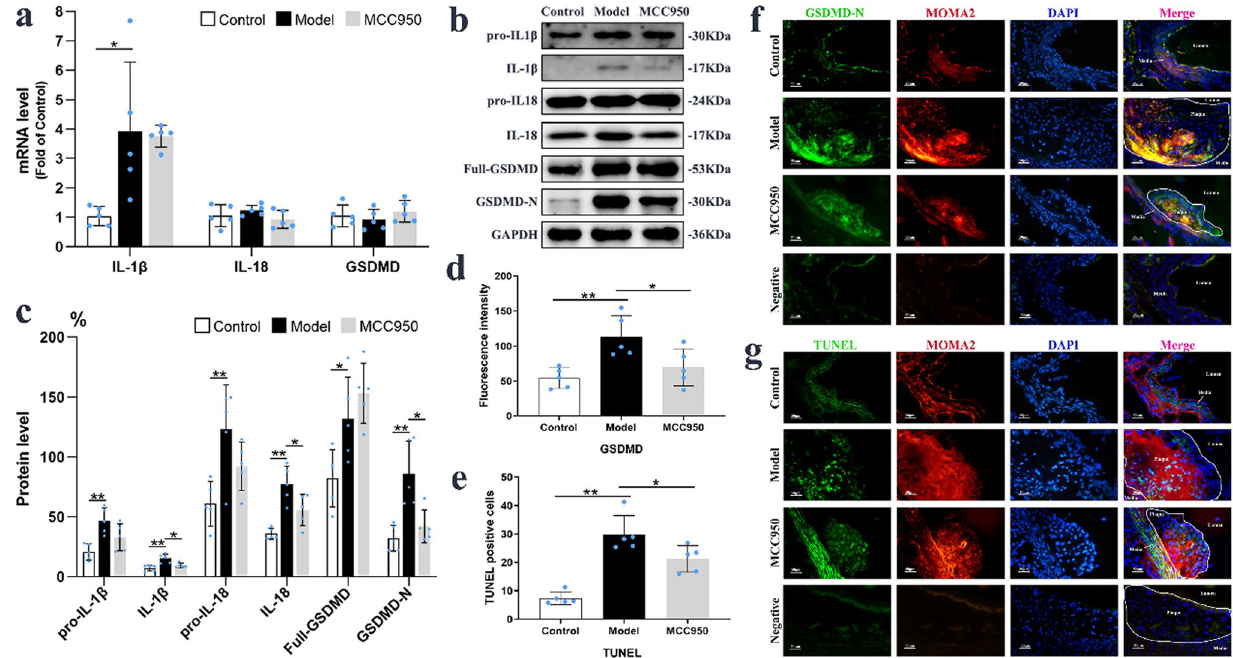
Figure 4. MCC950 mitigated NLRP3 mediated pyroptosis of macrophages within AS plaque. The mRNA and protein (n = 5/group) levels of IL-1β, IL-18, GSDMD-N in aorta were quantified and shown on ( a – c ). The representative images of GSDMD-N (green), MOMA2 (red) and DAPI (blue) in aortic root with immunofluorescent staining (n = 5/group) were exhibited on ( d , f ). TUNEL (green) and MOMA2 (red) stained pictures (n = 5/group) in atherosclerotic plaques and quantitation of TUNEL were shown on ( e , g ). GAPDH served as an internal control. The magnification was ×400, Scale bar = 50 μm. Data were presented as mean ± SD. * P < 0.05 was considered significant, ** P <